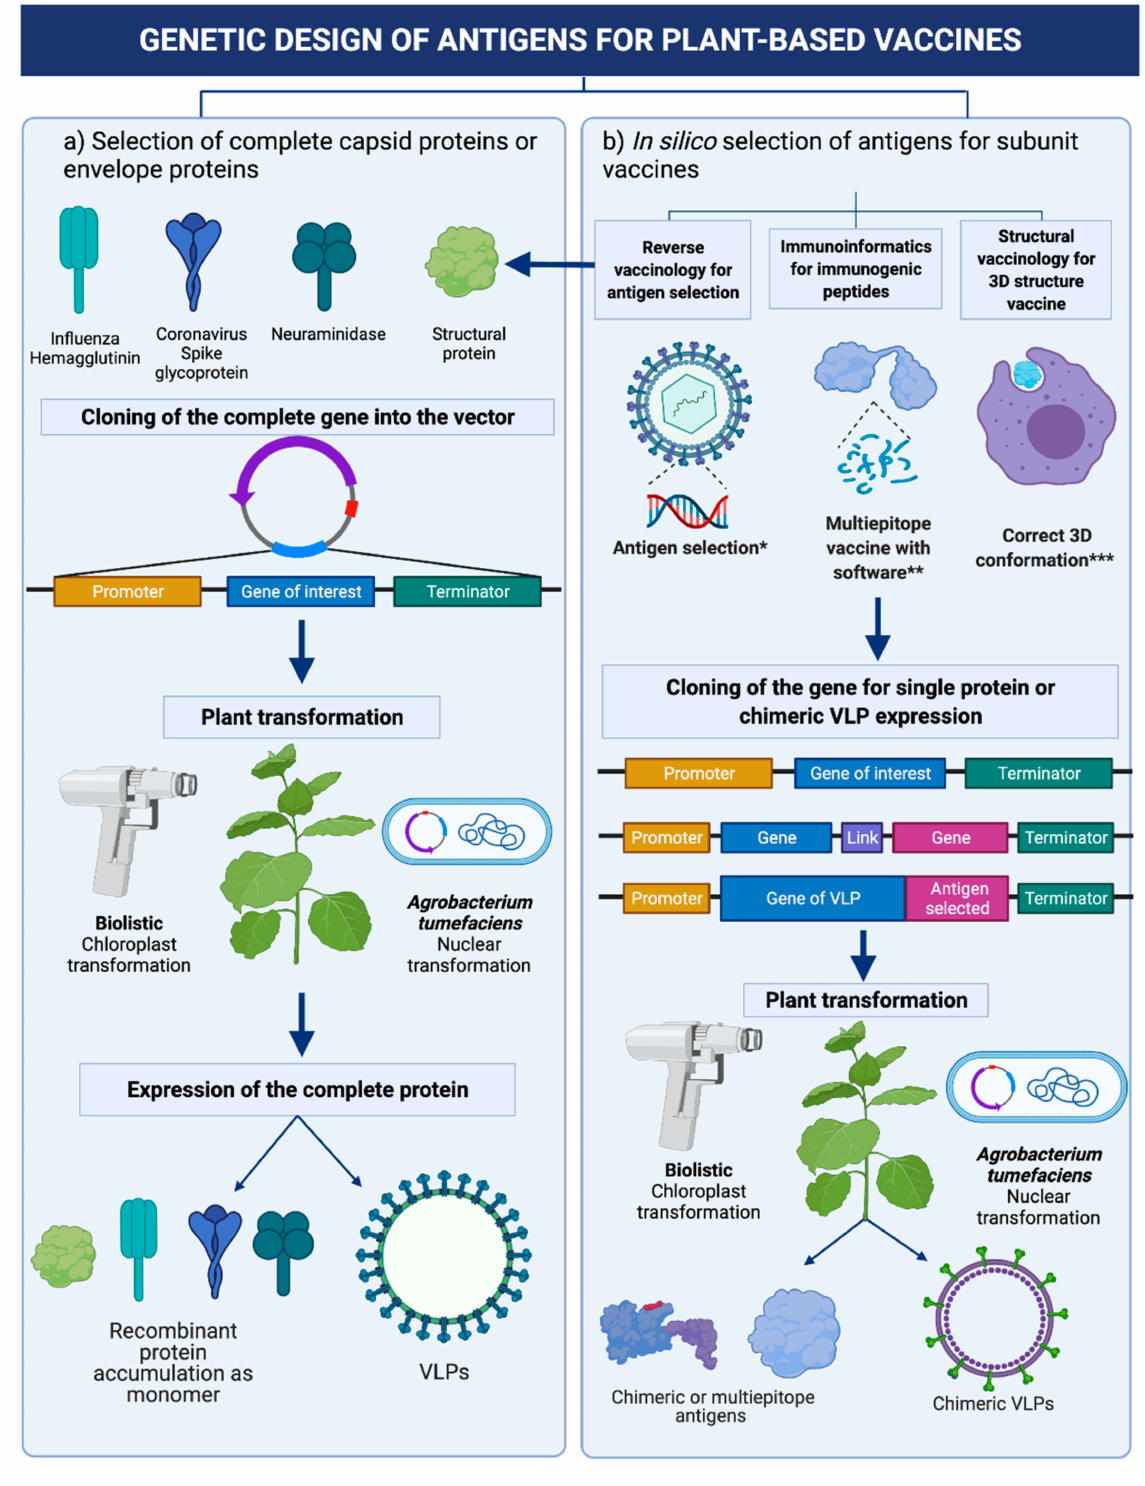
Figure 1. Strategies for designing and producing subunit vaccines using plants as biofactories. ( a ) Expression of complete antigenic viral protein (commonly surface proteins), ( b ) Expression of antigens (fragments of the viral proteins recognized by the immunological system) * Cellular location; adhesin properties; antigenicity; avoid similar host proteins. ** Cellular response by affinity to MHC I or CTL; or humoral response by affinity to MHC II or B lymphocytes. *** Tertiary structure prediction; refinement and validation; molecular docking or